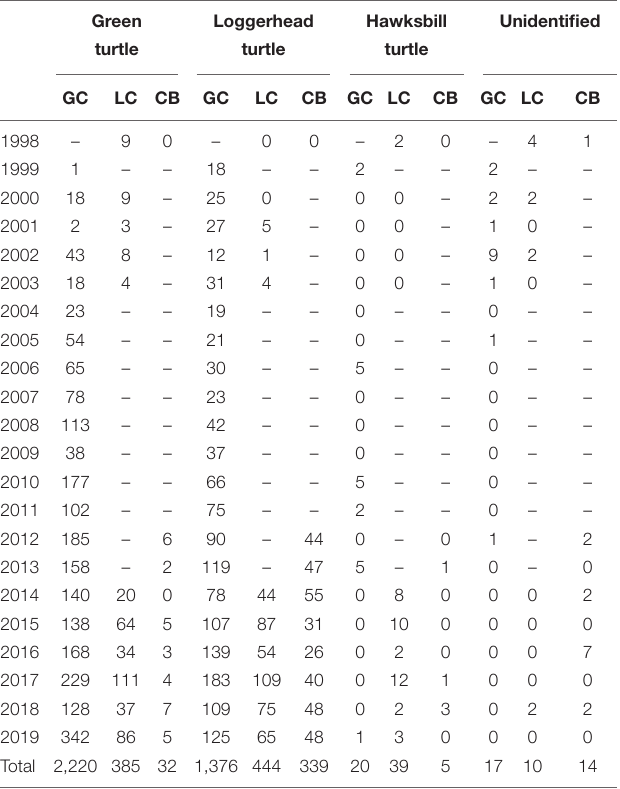
TABLE 1 | Total number of sea turtle nests recorded for each year of standardised monitoring in the Cayman Islands (GC, Grand Cayman; LC, Little Cayman; CB, Cayman